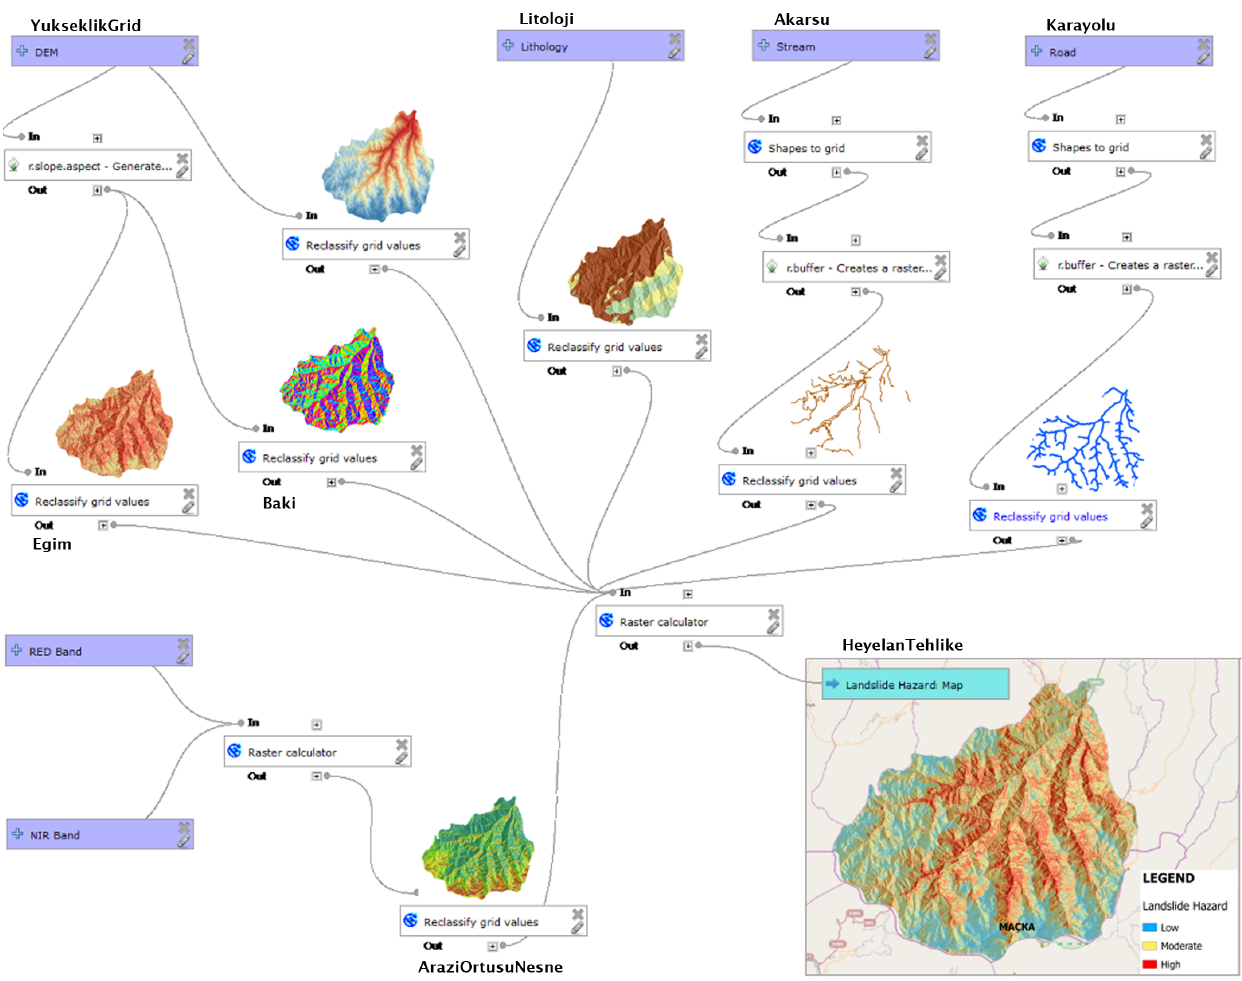
Figure 8. Processing steps and data sets for landslide hazard analysis in Macka, Trabzon, Turkey.